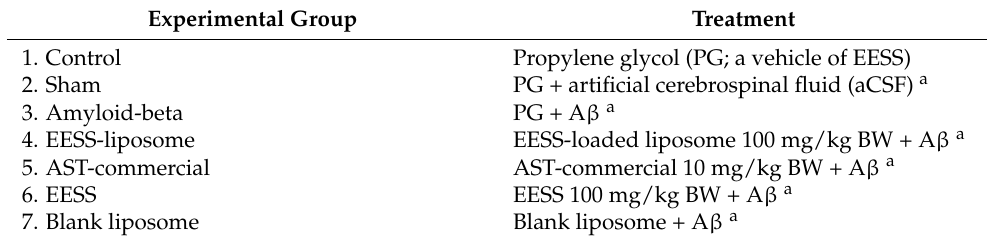
Table 1. The experimental groups and treatment of each